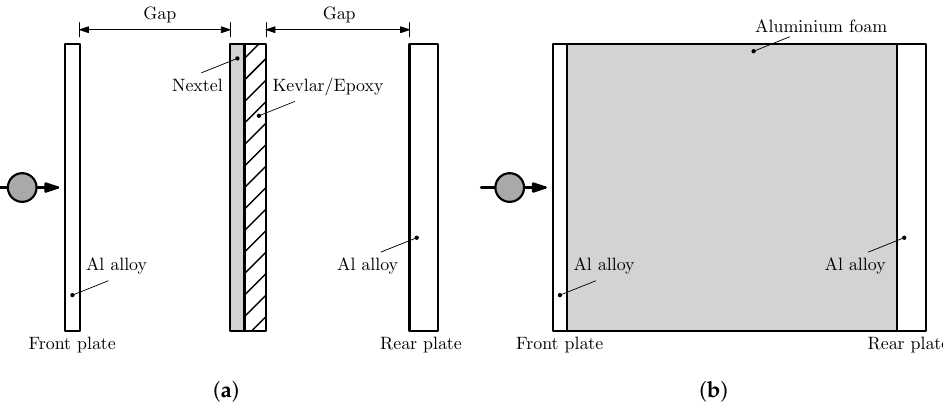
Figure 2. Schematics of alternative Whipple shield designs: ( a ) Stuffed Whipple and ( b ) aluminium foam sandwich (adapted from